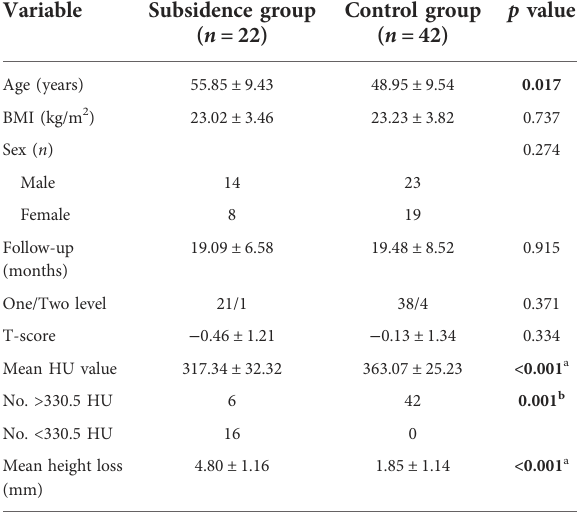
TABLE 2 Preoperative information and HU between patients with and patients without subsidence. Variable